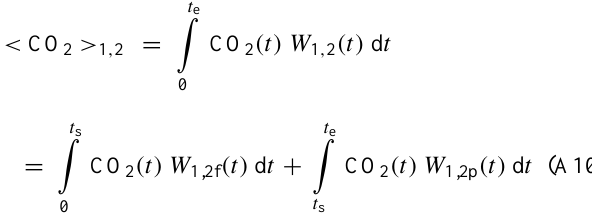
Fig. A1. The fraction of the air (entering the upstream flask at time t ) remaining in the flasks: at the time when the pressurizing period starts, t s , the fraction of the flushing air remaining (a) in the upstream flask, C 1 (t) and (c) in the downstream flask; at the time when the pressurizing is complete, t e , the fraction of the pressur- 0 (t) and (d) in the down- izing air remaining (b) in the upstream C 1 0 (t) . Note that at the time when the pressurizing period stream C 2 ends, the fraction of the flushing air in the upstream and the down- stream flasks will be different as a result of flushing air that is mov- ing from the upstream flask into the downstream